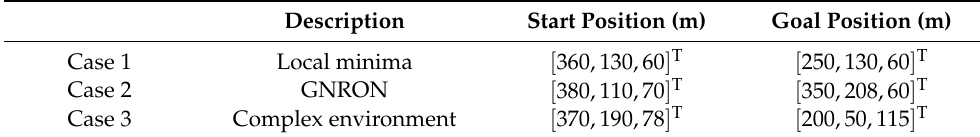
Table 4. Start and goal positions of the quadcopter for each